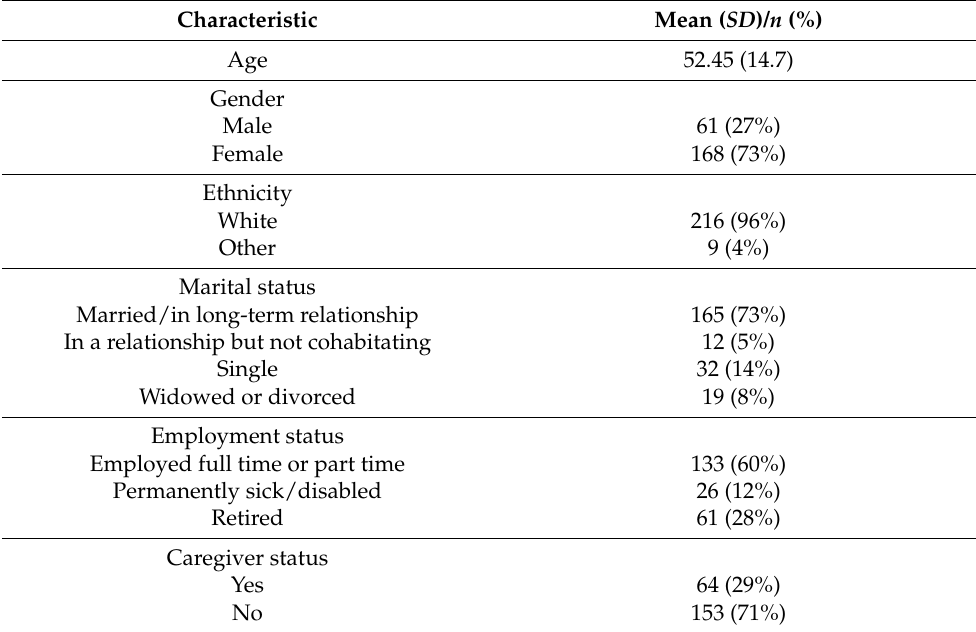
Table 1. Patient participant personal and cancer specific